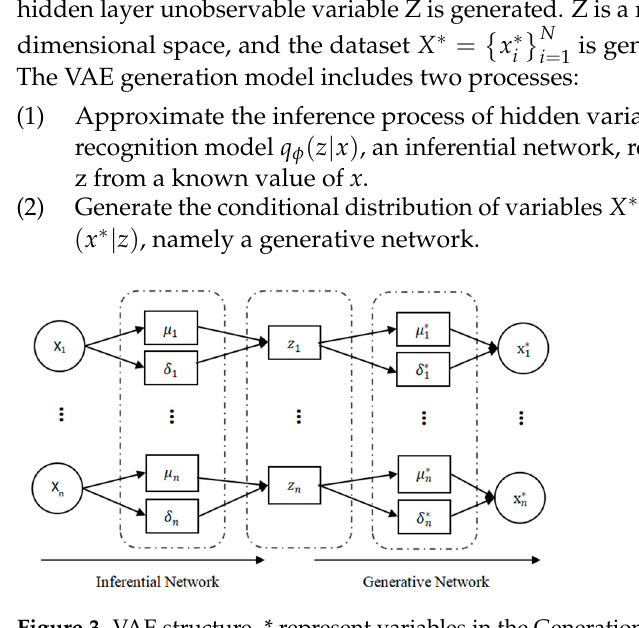
Algorithm 1. Specific description of the algorithm